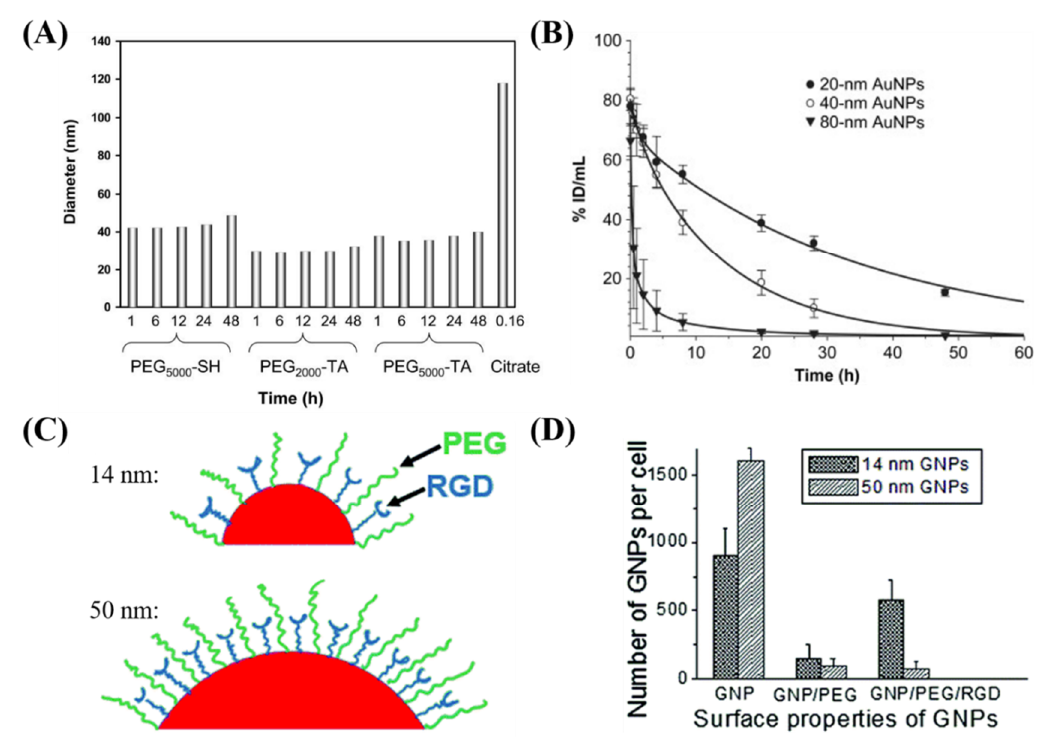
Figure 4. Effect of functionalization on cellular uptake of gold nanoparticles. ( A ) Diameter as measured using dynamic light scattering of GNPs functionalized with different PEG moieties, compared to bare GNPs. ( B ) Pharmacokinetics of different sized PEGylated GNPs expressed as a percentage of injected dose per gram of tissue in mice. ( C ) GNPs can be functionalized with PEG for stability and a peptide containing integrin binding domain RGD for targeting. ( D ) The use of the RGD functionalized GNPs allowed for improved uptake into tumors cells compared to GNPs functionalized with solely PEG. Reprinted (adapted) with permission from [82] and [76]. Copyright 2009 Elsevier. Copyright 2015 Royal Society of Chemistry.